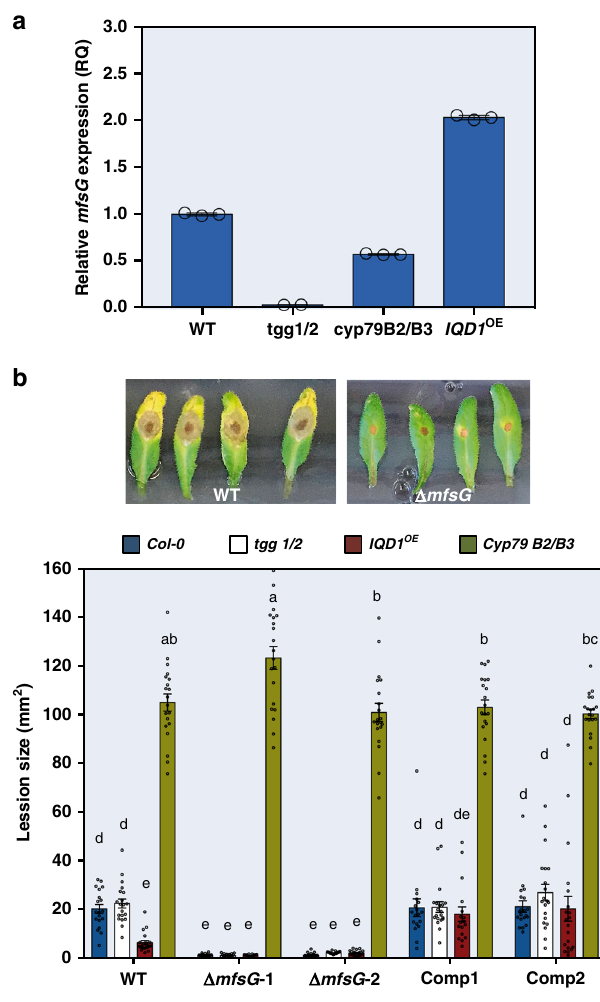
Fig. 4 mfsG expression levels and pathogenicity assays on Arabidopsis plants. a mfsG expression analysis 48 h after inoculation of wild-type B. cinerea on Arabidopsis wild type (WT; Col-0 ), IQD1 OE , cyp79B2/B3 and tgg1/2 , n = 3. b Pathogenicity of B. cinerea wild type (WT), knockout mutants ( Δ mfsG ), and complemented mutants (Comp) was evaluated on different Arabidopsis genotypes by measuring lesion sizes 72 h after inoculation with the different B. cinerea strains (representative pictures are presented for Col-0 Arabidopsis leaves inoculated with WT B05.10 or Δ mfsG ). Average lesion sizes of 17 – 20 leaves of each genotype are presented together with the standard errors for each average. Different letters above the columns indicate signi fi cant difference at P < 0.05, as